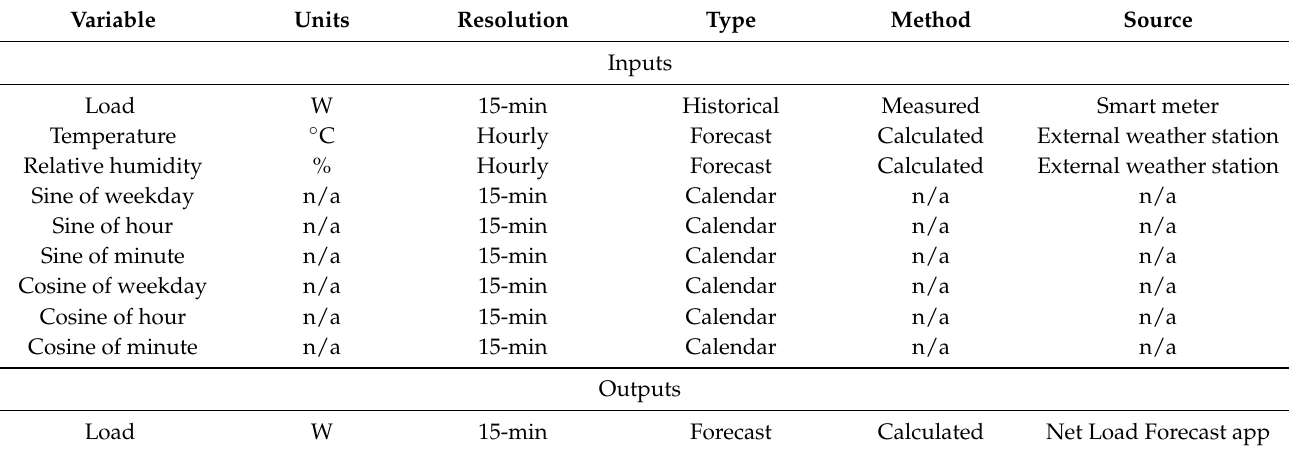
Table 2. Detailed list of inputs and outputs for Load Forecast in the Net Load Forecast application.